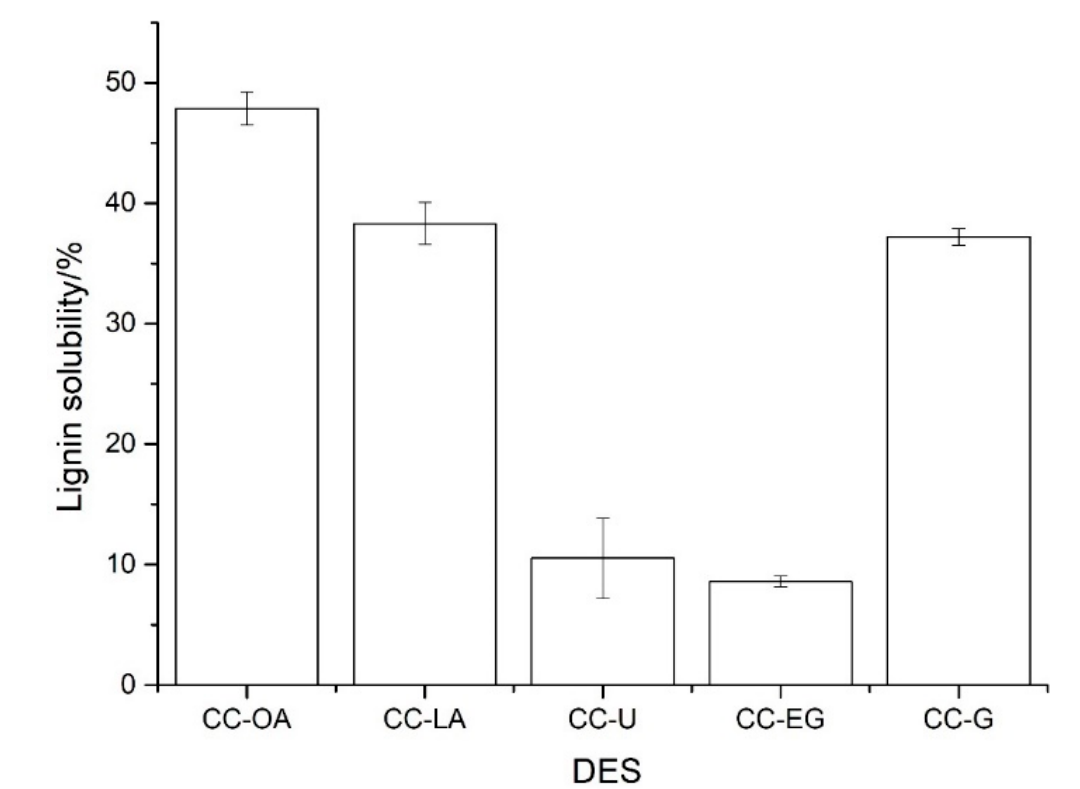
Figure 1. Solubility of lignin in d eep eutectic solvents （ DESs ） .